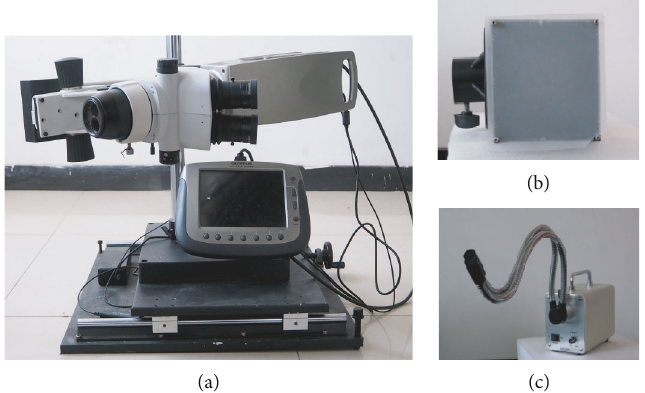
Figure 1: The photographs of the high-speed camera and light source.